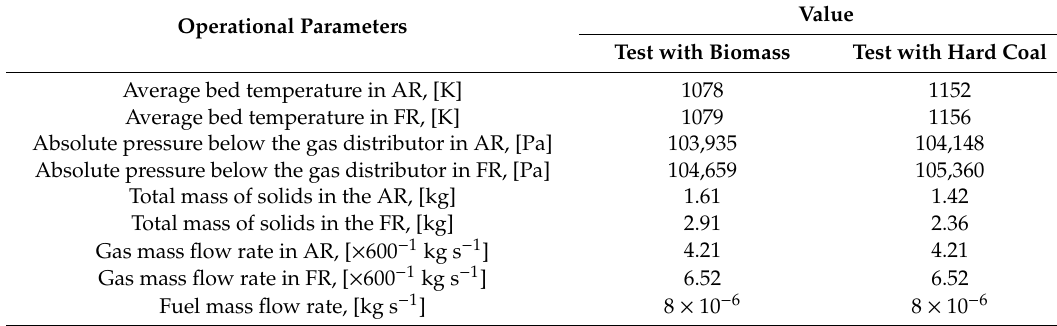
Table 2. The operational conditions of the FB-CLC-SF unit. Operational